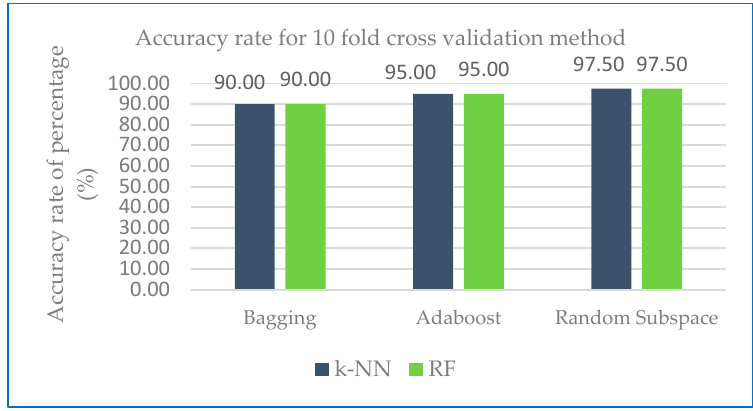
Table 6. Overall performance measure ensemble classifiers for 10-fold cross validation method.